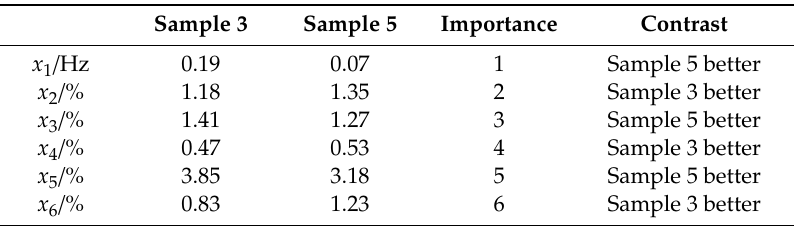
Table 7. Comparison of samples 3 and 5.